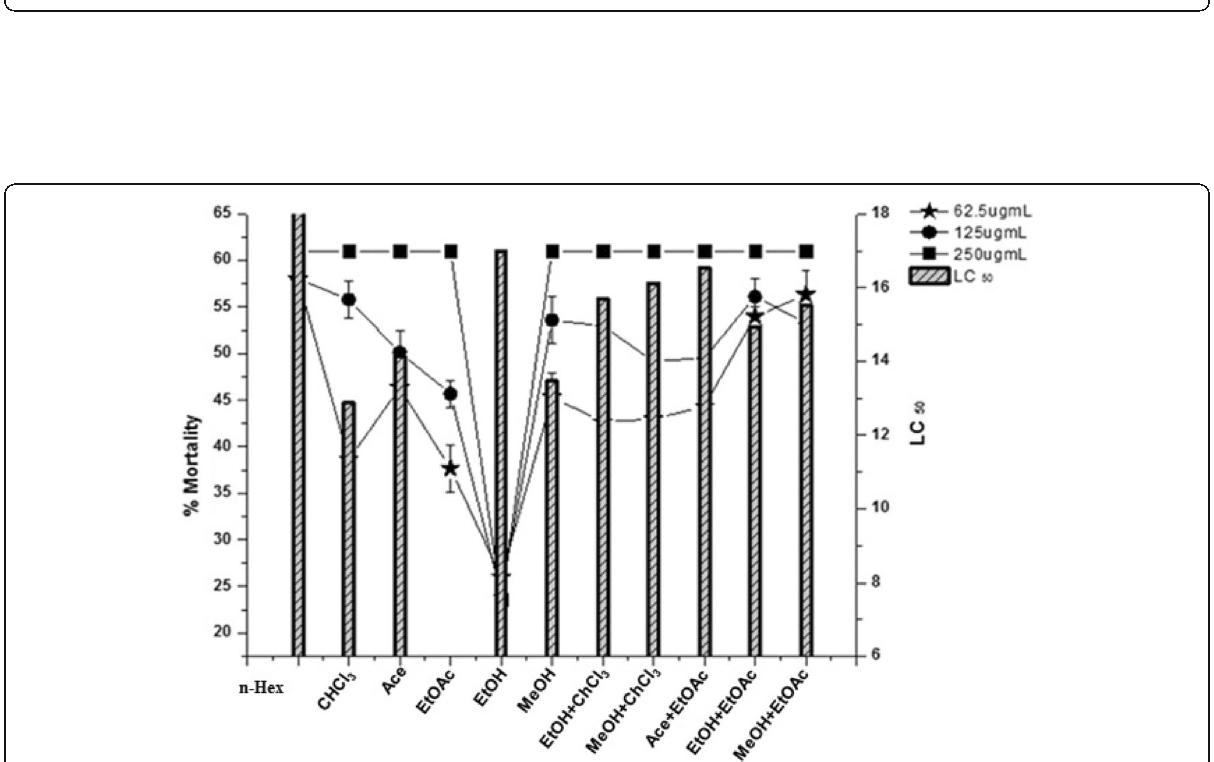
Fig. 3 Protein kinase inhibition potential of A. jacquemontii extracts. Values are presented as Mean + SD, LSD test for pair wise comparison, not significantly different ( P > 0.05). GOI of standard Surfactin comes out to be 17 ± 1.2